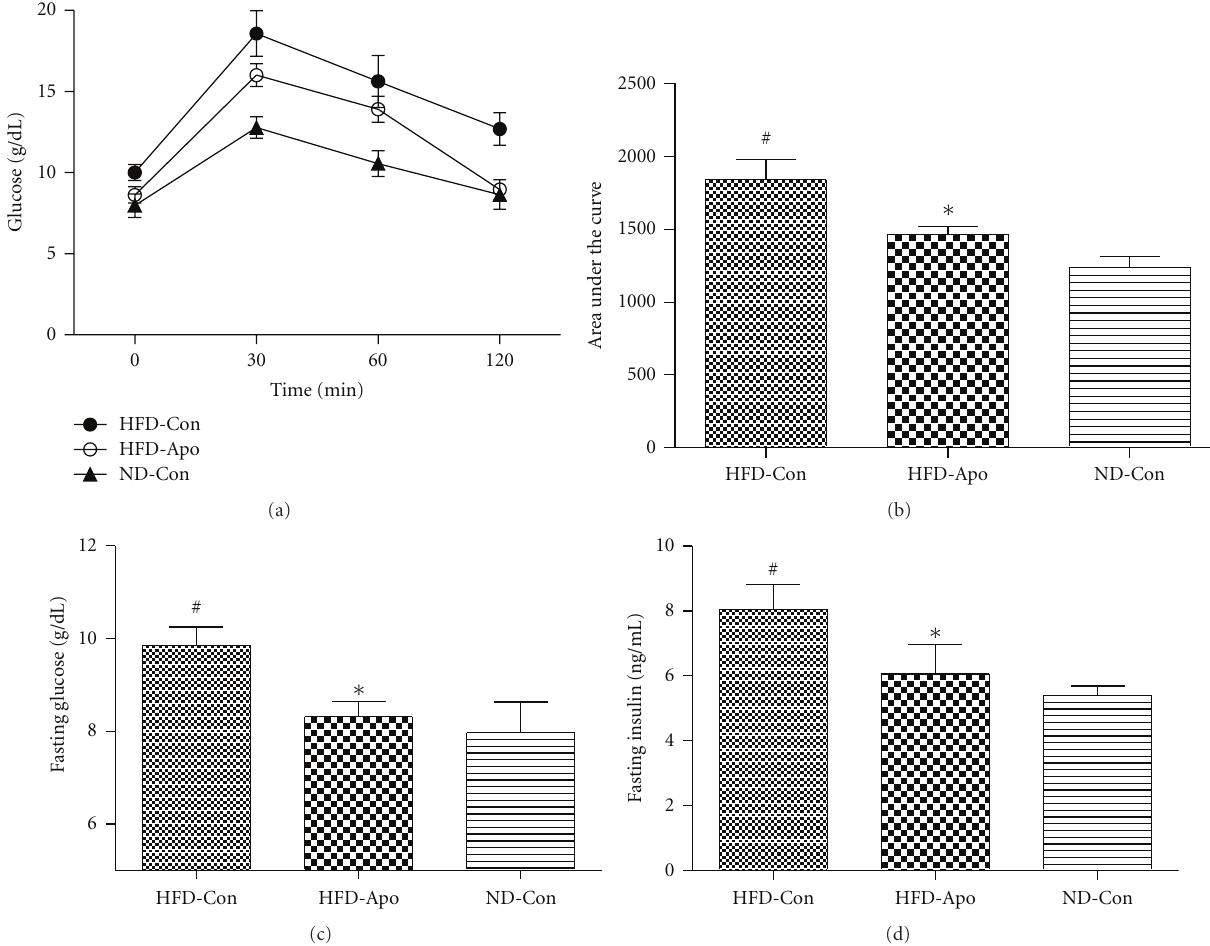
Figure 2: E ff ect of apocynin on obesity-induced glucose intolerance. (a) IPGTTs was performed by injection intraperitoneally of 1g/kg glucose after 6-hour fasting, and blood samples were drawn from tail veins after 0, 30, 60, and 120 min. (b) Area under the curve was measured as a parameter of insulin resistance. Significant di ff erence was detected between HFD-Apo group and HFD-Con group. (c) Fasting glucose levels. There is a significant di ff erence between HFD-Apo group and HFD-Con group. (d) Fasting insulin levels. The fasting insulin level of the HFD-Apo group is lower than that of HFD-Con group. # P < . 05 versus ND-Con group, ∗ P < . 05 versus HFD-Con